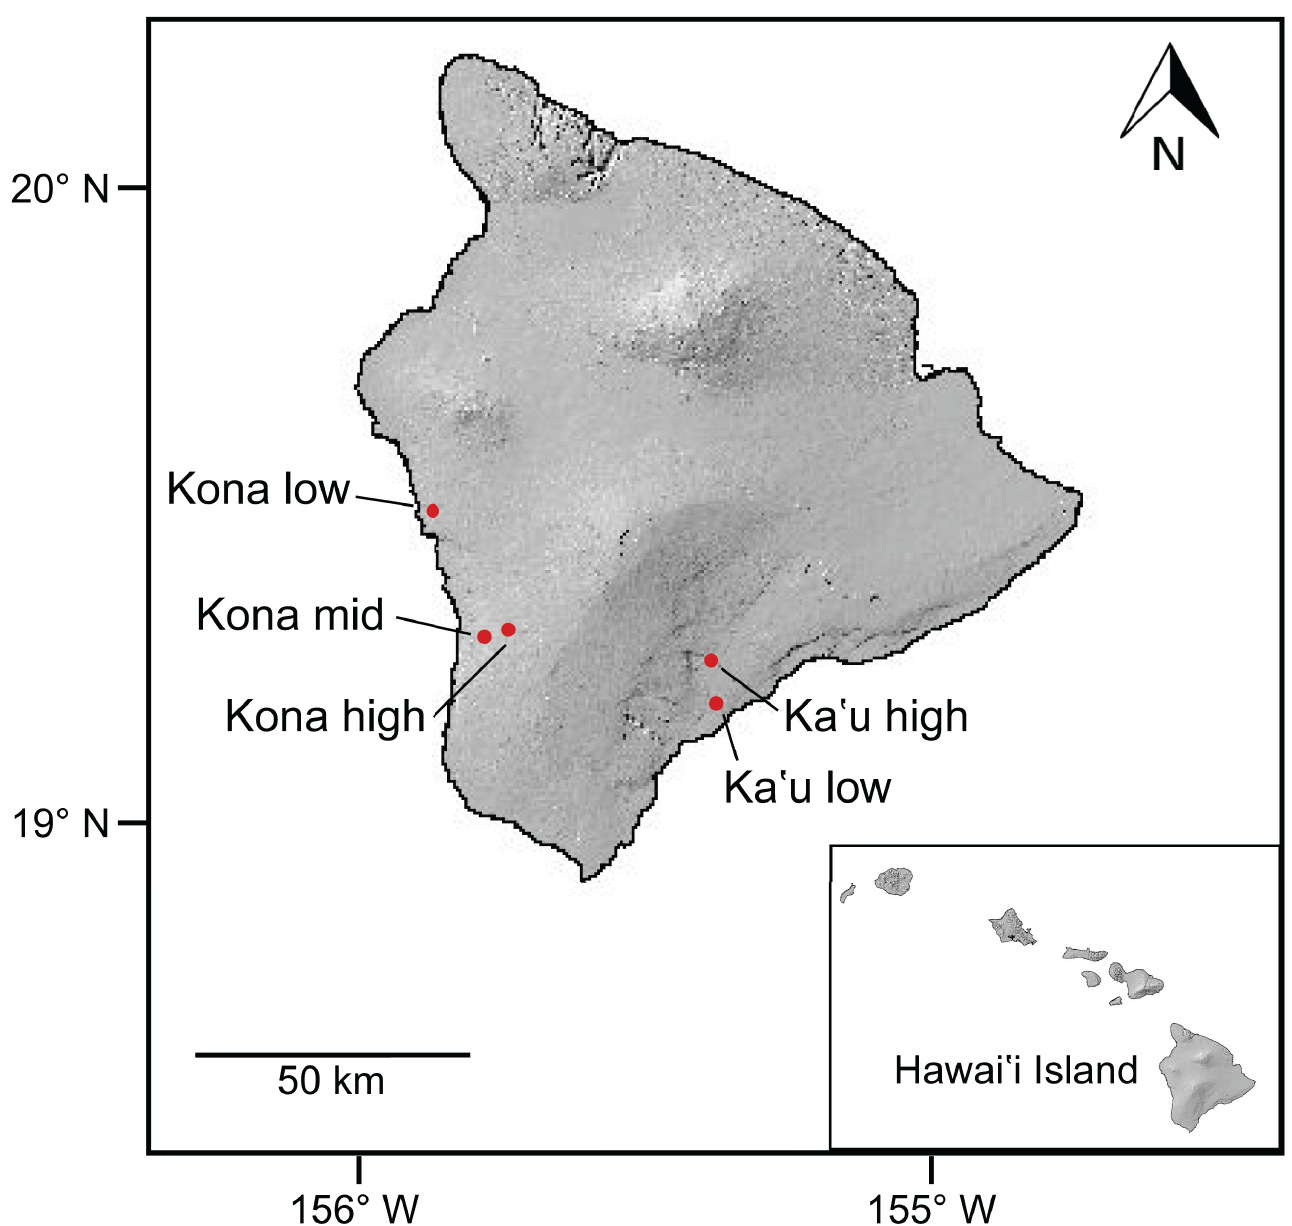
Fig 1. Map of Hawai‘i Island showing locations of the five study sites. Three sites were located in the Kona district on the west side of the island, and two sites were located in the Ka‘u district on the southeast side of the island. Kona sites represented low (427 m), mid (610 m), and high (792 m) elevations, while Ka‘u sites represented low (279 m) and high (778 m) elevations. Inset map shows the main Hawaiian Islands and the location of Hawai‘i Island within the archipelago. https://doi.org/10.1371/journal.pone.0218321.g001 sites at three elevations: low (427 m), mid (610 m), and high (792 m); sites selected in Ka‘u rep- resented low (279 m) and high (778 m) elevations (Fig 1). Four of the five sites were planted with Coffea arabica var. typica that was grown in full sun. The Ka’u low site was planted with Coffea arabica var. catuai and had sparsely planted Samanea saman (monkeypod) trees that provided shade to a small fraction of the coffee plants. Ground cover varied among sites from soil to rocks, grass, or perennial peanut.